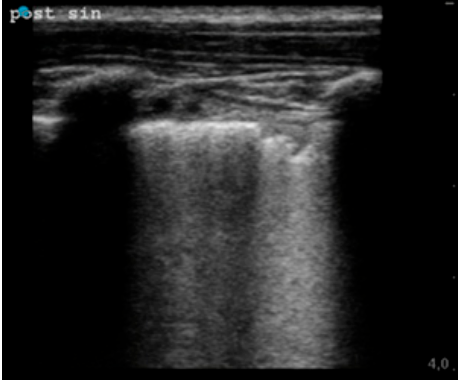
Figure 1. The presence of several but non-coalescent B-lines in the pulmonary parenchyma of a child with COVID-19 infection.